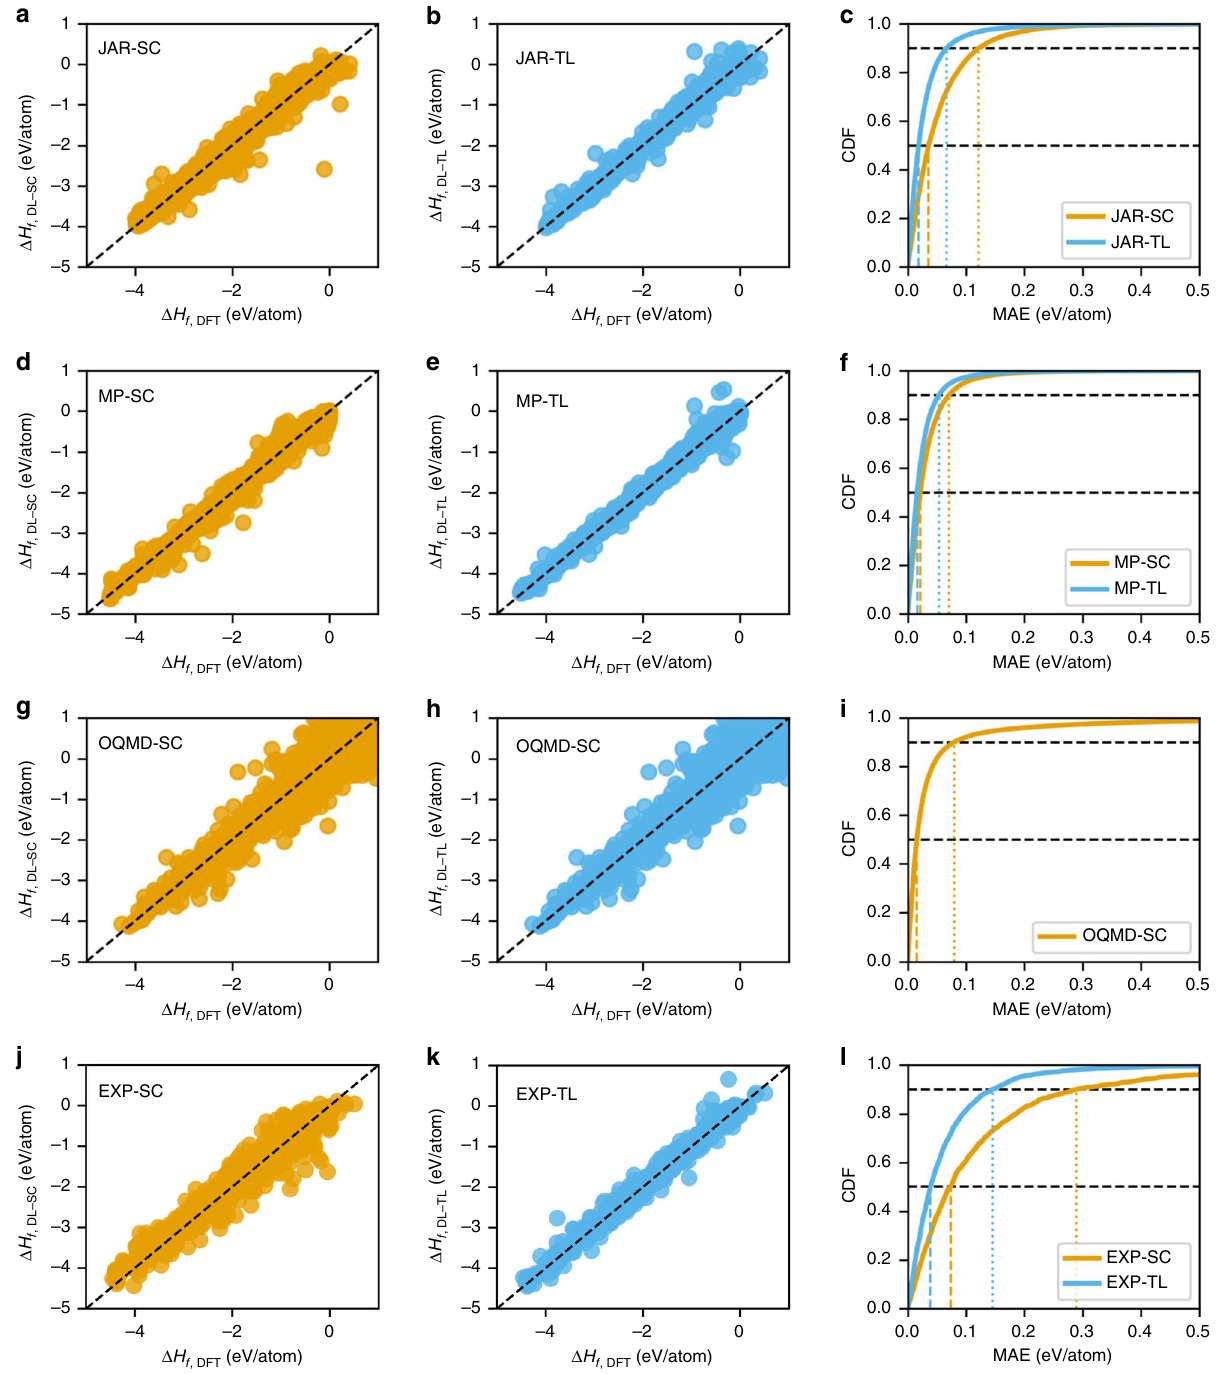
Fig. 4 Prediction error analysis. For OQMD-SC, ElemNet model is trained from scratch using a 9:1 random split into training and test (validation) set of OQMD; here, we show the predictions on the test set. For other (smaller) data sets, we aggregate the predictions on the test (validation) sets from each split of the 10-fold cross-validation. The four rows represent the four data sets: a – c JARVIS (JAR), d – f Materials Project (MP), g – i OQMD, and j – l the experimental observations (EXP); fi rst a , d , g , and j and second b , e and k (except h) columns of each row show the predictions using the model trained on the particular data set from scratch (SC) and using transfer learning (TL), respectively, the third column c , f , i , and l shows the corresponding CDF of the prediction errors using models trained from scratch (SC) and using transfer learning Performance on experimental data . Next, we analyze the per- 1,643 samples. The performance of different models on the formance of the prediction models trained on different DFT- experimental data set is shown in Table 3. For models trained on computed data sets (both trained from scratch and with transfer experimental data, we report the performance on test (validation) learning from the OQMD-SC model), by evaluating their sets from the 10-fold cross-validation. For JARVIS and the performance on the experimental observations containing Materials Project, we report the mean and standard deviation of